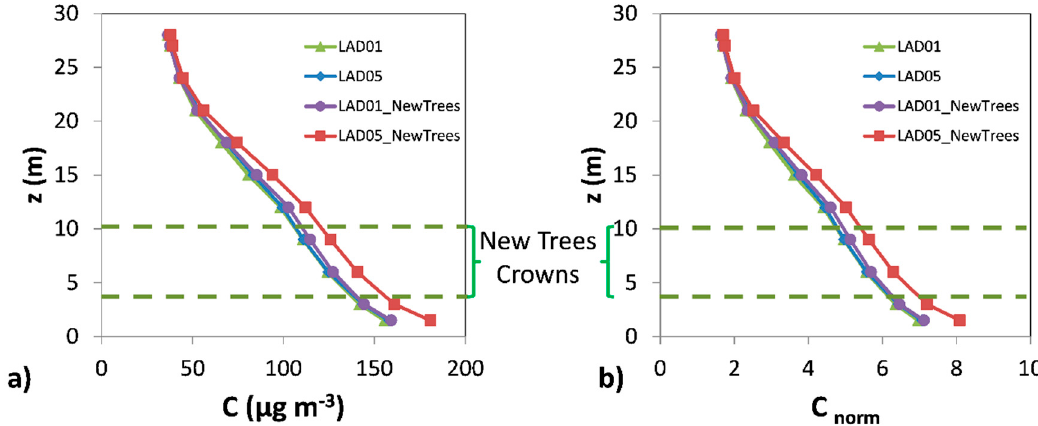
Figure 5. ( a ) Vertical profiles of spatially-averaged concentration within the study street. ( b ) Same as ( a ) but for normalized concentration (C norm ). Green dashed lines indicate the crown location of the new trees located in the study street.